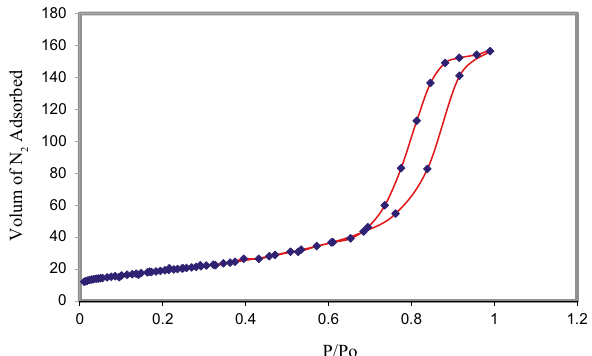
Figure 3. N2 adsorption desorption isotherm of Co/Zn-Al 2 O 4 catalyst.